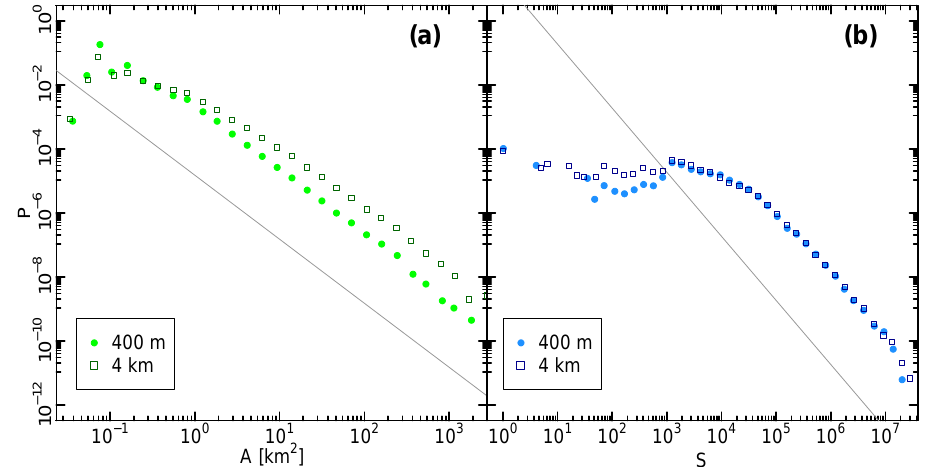
Figure 3. Probability density of city size in terms of area and population. ( a ) Cluster area distribution p ( A ) , as obtained by applying the City Clustering Algorithm (CCA) to global land cover data and extracting all urban clusters on the globe. For A > 0.1km 2 we estimate ζ A ≈ 1.93 for l = 0.4km (249,512 clusters) and ζ A ≈ 1.75 for l = 4km (46,754 clusters); ( b ) Cluster population distribution p ( S ) , as obtained from associating population settlement points with the urban clusters identified by means of CCA. For S > 10 4 we estimate ζ S ≈ 1.85 for l = 0.4km and ζ S ≈ 1.75 for l = 4km. In both panels: l = 0.4km (circles), l = 4km (squares). The solid grey lines have slope −